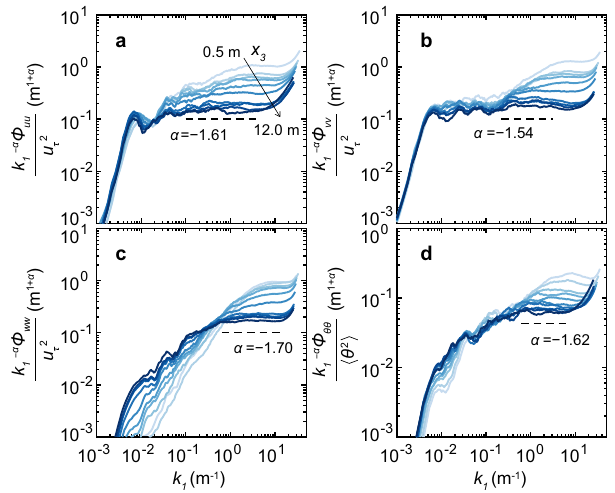
Fig. 2 | Compensated one-dimensional PSDs of the fl uctuating fi elds for the observed particle-free dataset. a – d The compensated velocity PSDs (streamwise component k (cid:2) α 1 ϕ uu , spanwise component k (cid:2) α 1 ϕ vv , and vertical component k (cid:2) α 1 ϕ ww ) and ambient temperature PSDs ( k (cid:2) α 1 ϕ θθ ) are divided by the squared friction velocity (i.e., u 2 τ ) and their variances (i.e., 〈 θ 2 〉 ), respectively. The PSDs are smoothed using a 25% bandwidth moving fi lter 60 and shown at ten heights from 0.5m (light blue) to 12m (dark blue). The scaling exponents of the PSDs, α , are determined by fi tting the PSDs at 12m height with a power function of the streamwise wavenumber k 1 , i.e., ∼ k α 1 within the ranges of k 1 denoted by the hor- izontal dashed